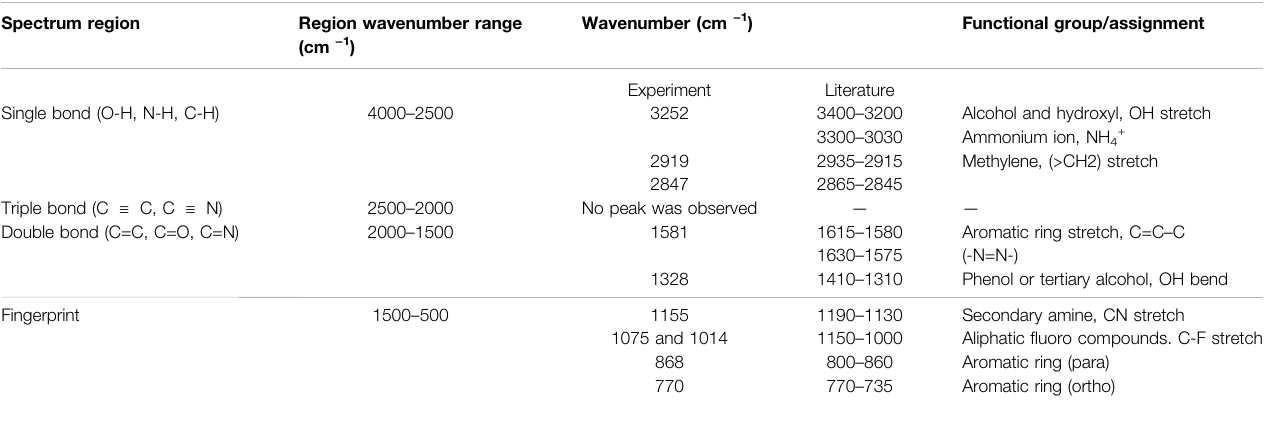
TABLE 6 | FTIR peaks analysis (adapted from (Nandiyanto et al., 2019)). Spectrum